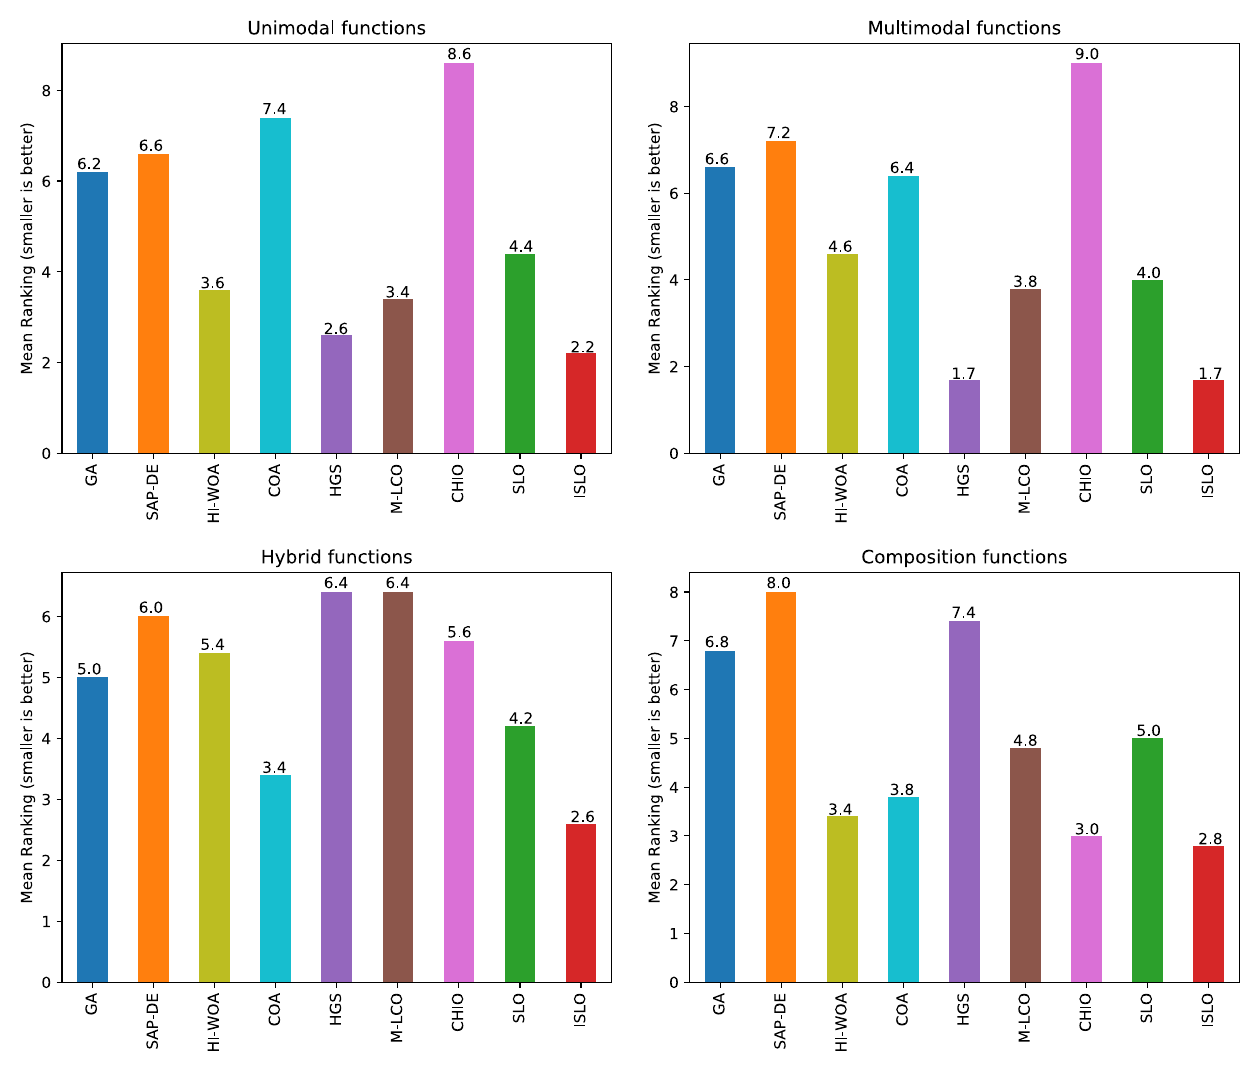
Fig. 6 Visualization of mean ranking on unimodal, multimodal, hybrid, and composition functions of compared